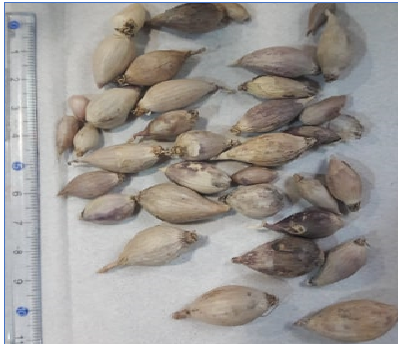
Figure 4. Allium subhirsutum L. (bulbs) purchased from a local market in Hail